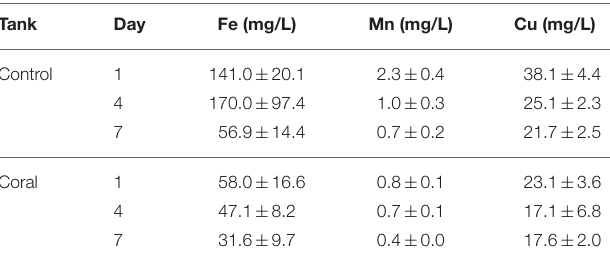
TABLE 2 | Metal concentrations # in aquaria water.